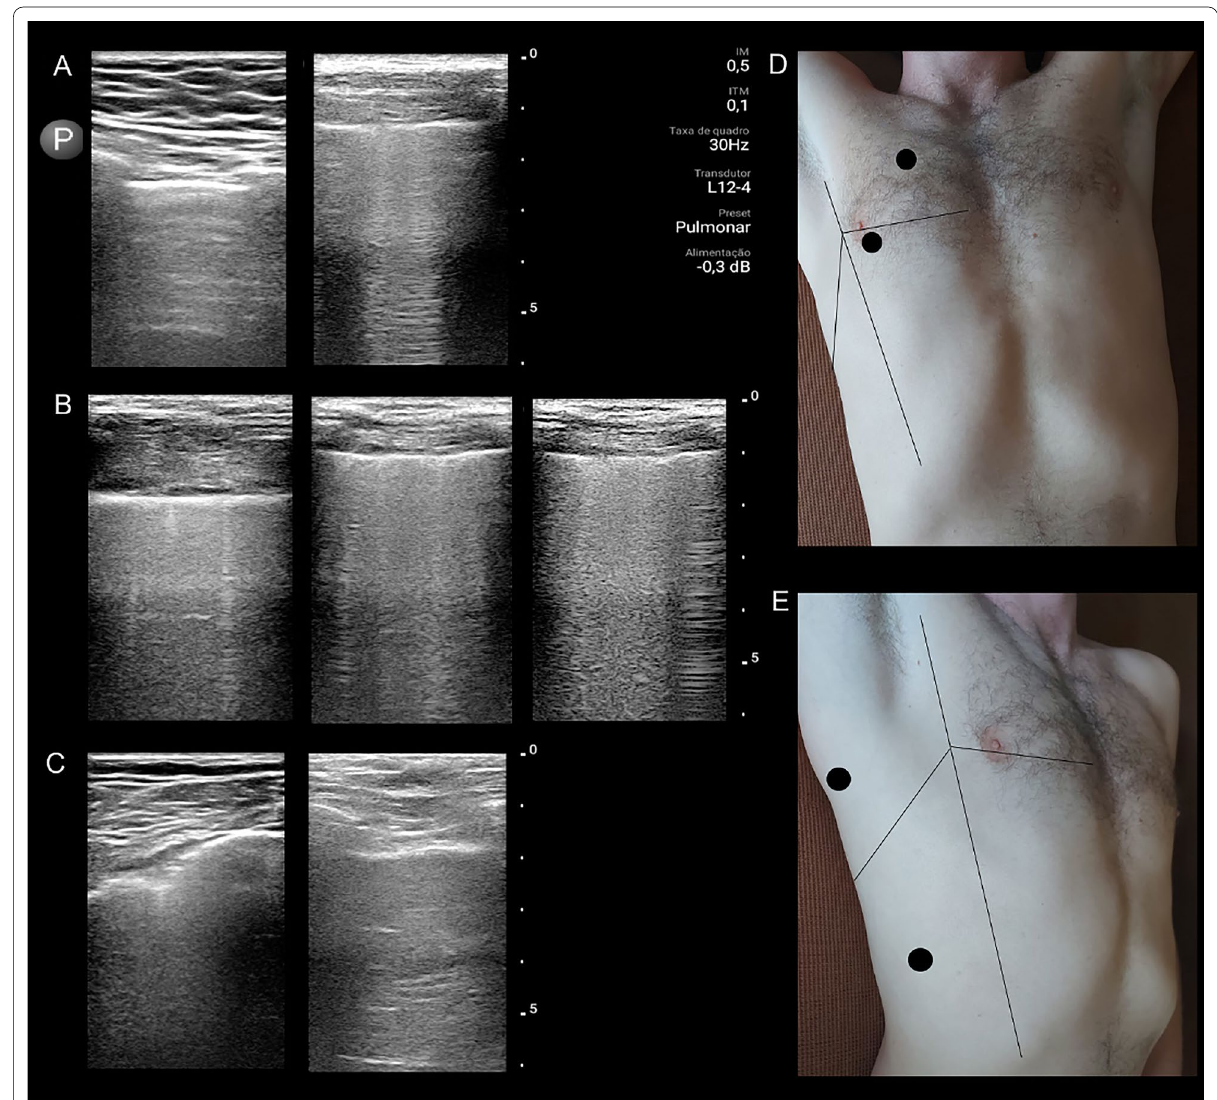
Fig. 1 An example of lung ultrasound (LUS) findings and the procedure for calculation of LUS score. Pleura ( A ) was scored 1 point (left image) or 2 points (right). The B-lines presence ( B ) scored 1 points (left), 2 points (middle) or 3 points (right), whereas consolidations presence scored 4 points (left) or 5 points (right). The hemithorax regions evaluated are also shown including the initial probe points at each region ( D and E